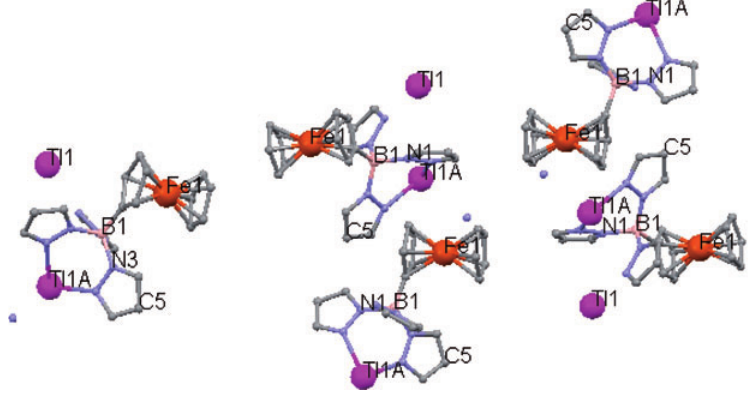
Figure 2 View of the structure of (cp)Fe(C